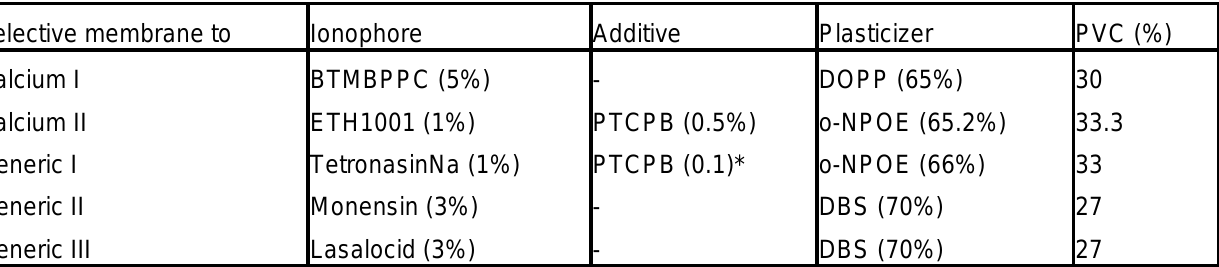
Table1. Formulation of the ion-selective membranes employed in the construction of the potentiometric sensor